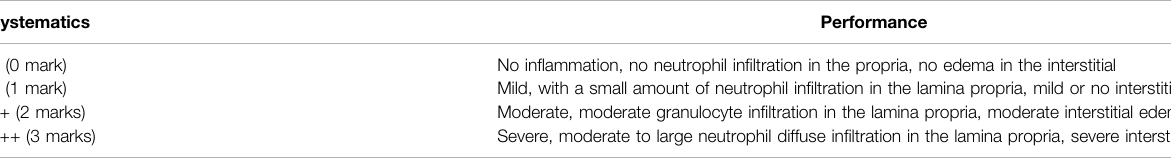
TABLE 1 | Evaluation of colonic pathological tissue in fl ammation grade. Systematics